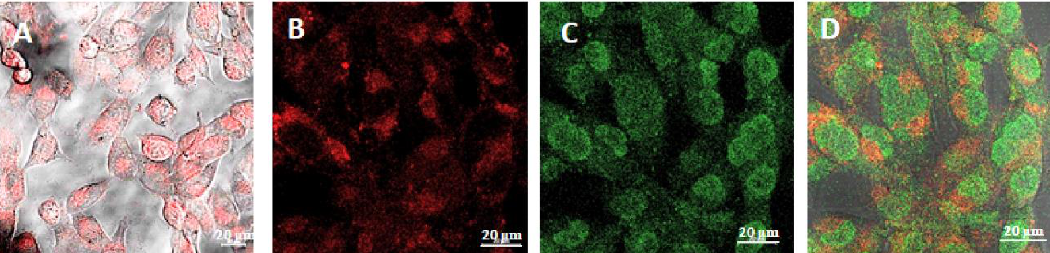
Figure 5. Representative images of confocal microscopy analysis of theT98G cell line treated with the fluorescent HSA-Cy5-HcyTFAc-B 12 H 11 conjugate (20 µM) for 1.5 h. Cell nuclei were stained with SYBR Green I. HSA-Cy5-HcyTFAc-B 12 H 11 is visible as a red color. Scale bars: 20 μm. Panel ( A ): Live cell image: T98G cells were incubated with the conjugate for 1.5 h and washed three times with PBS. Panels ( B – D ): The cells were fixed with 2% formaldehyde. Panel ( D ): Merged ( B , C ).